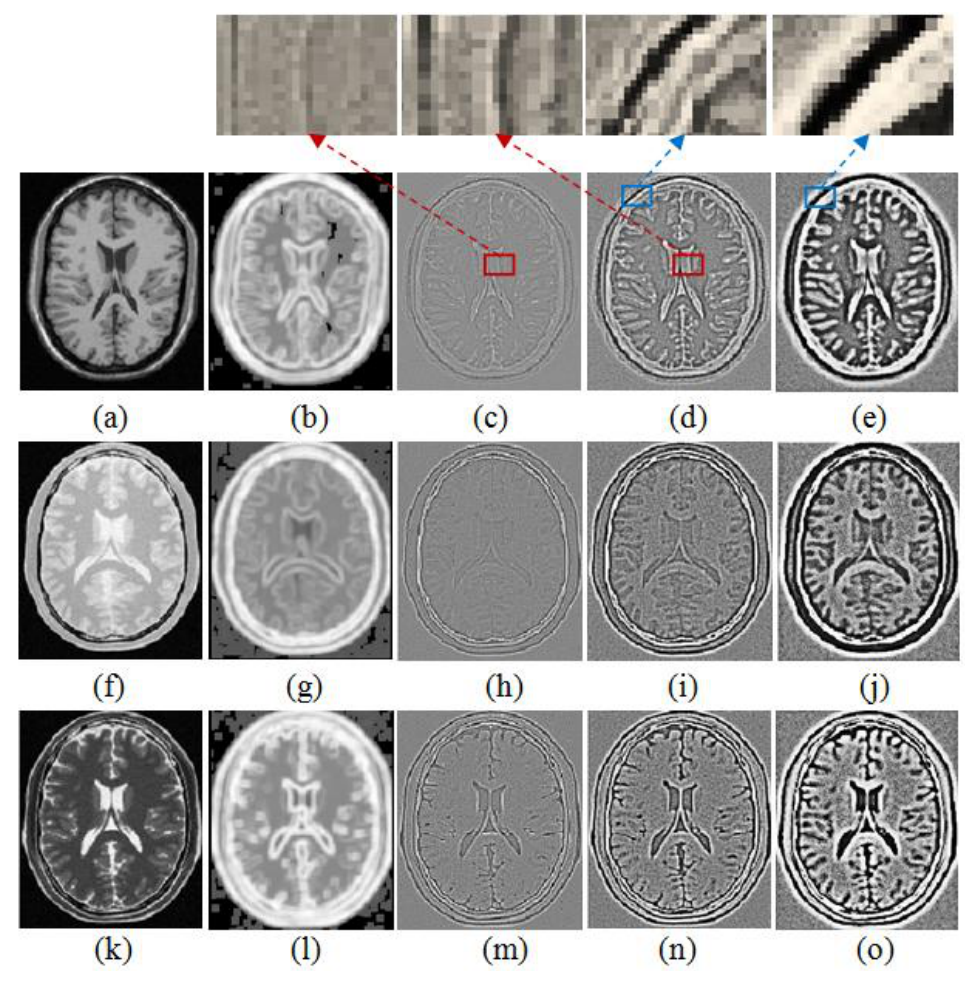
Figure 4. Entropy image and WLD with different R of the various MR images. ( a )